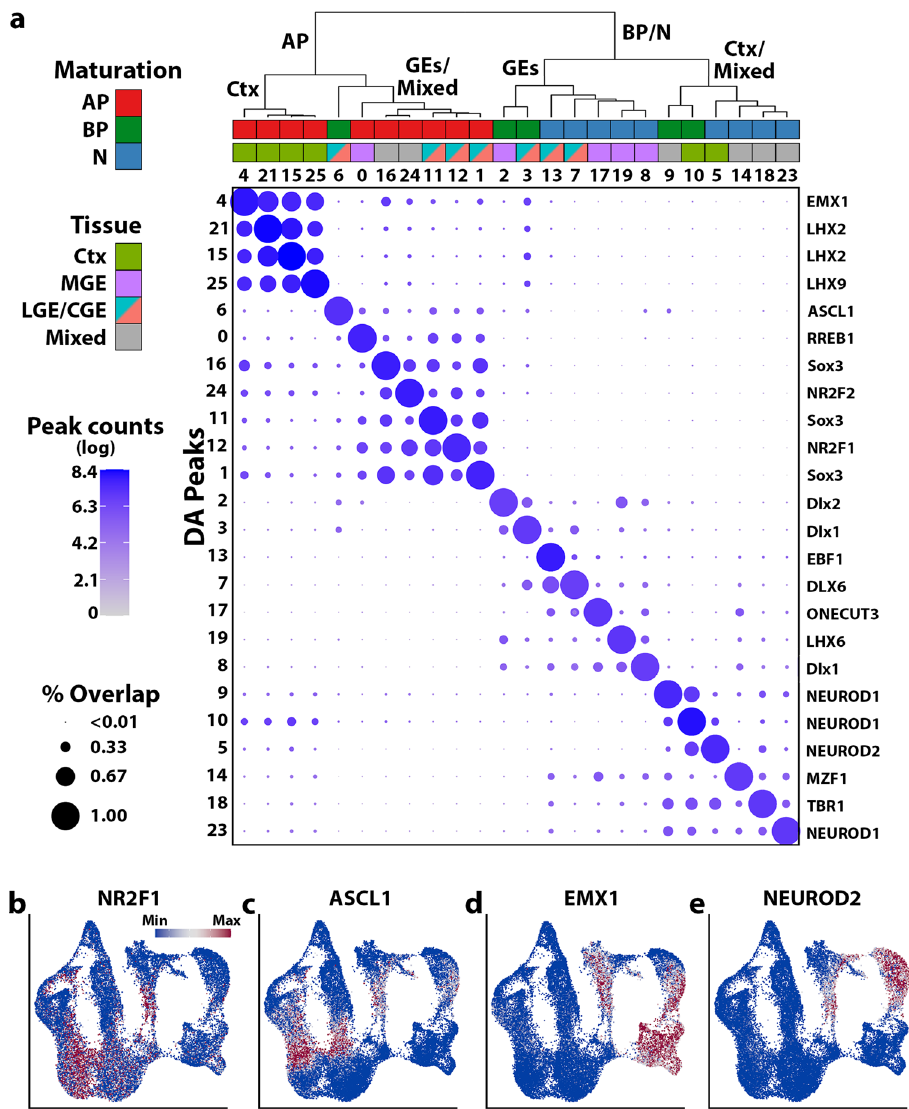
Fig. 2 Differentially accessible peaks are cluster and lineage-speci fi c in the mouse embryonic forebrain. a Embryonic snATAC-Seq dot plot of differentially accessible peaks (DA peaks) for each cluster. Dot diameter indicates the percent of DA peaks from one cluster (column cluster labels) which are detectable in any other cluster (row cluster labels). Color intensity represents the total DA peak count per cluster. Hierarchical clustering was performed using correlation distance and average linkage. Names of representative cluster-enriched transcription factor binding motifs in DA peaks are listed to the right of the dot plot. b – e UMAP plots of nuclei colored by ChromVAR global motif deviations ( Z -scores) for NR2F1, ASCL1, EMX1, and